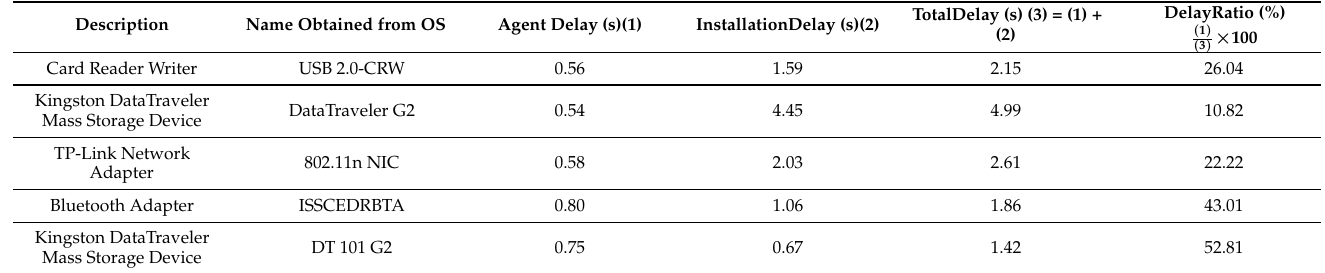
Table 1. Performance results for some devices tested with ratio